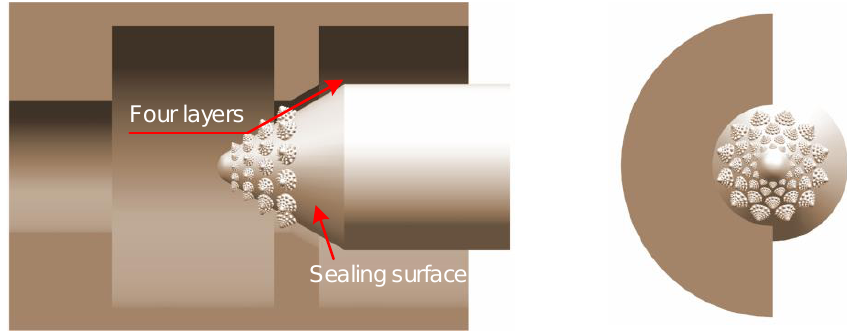
Figure 10. Structure of valve port field.